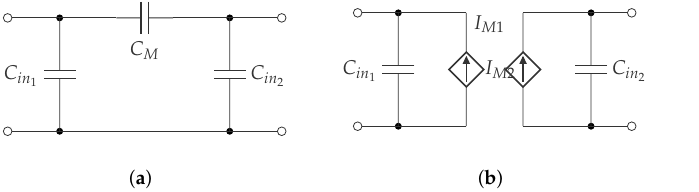
Figure 12. Equivalent circuit models for the capacitive coupler. ( a ) Pi-model, ( b ) equivalent model with voltage controlled current sources with I M 1 = j ω C M V C